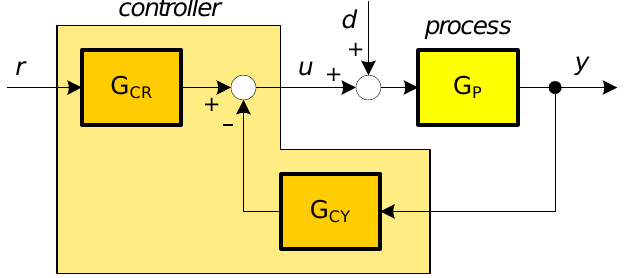
Figure 1. General closed-loop scheme with a two-degrees-of-freedom (2-DOF) controller.